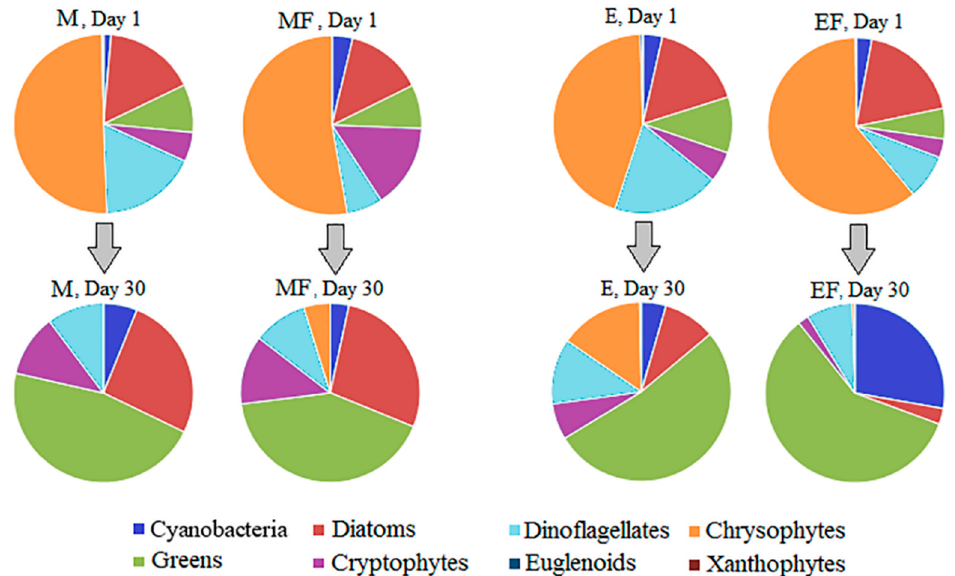
Figure 5. Taxonomic structure of phytoplankton community on Day 1 and Day 30 in M—mesotrophic conditions, MF—mesotrophic conditions with introduced fish, E—eutrophic conditions, EF—eutrophic conditions with introduced fish.